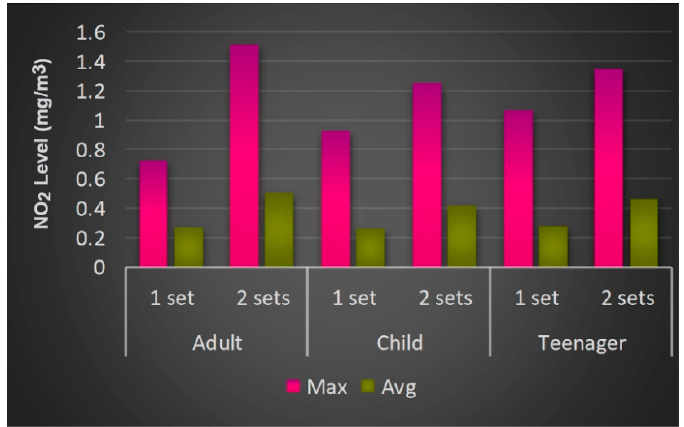
Figure 7. Maximum and average levels of exposure to NO 2 for the three pedestrians at the traffic light—one set of vehicles vs two sets.